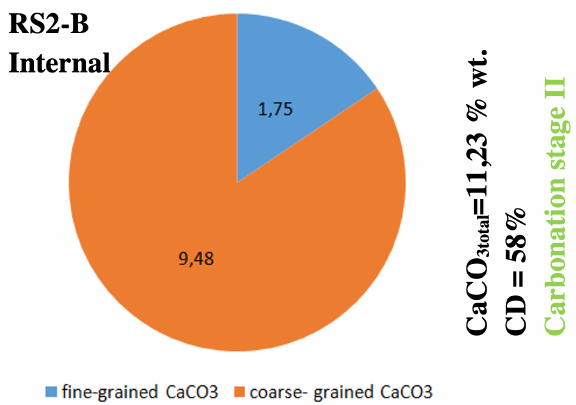
Figure 9. The amount of CaCO 3 (% wt.) in the in- ternal layer of the unprotected concrete sample RS2-